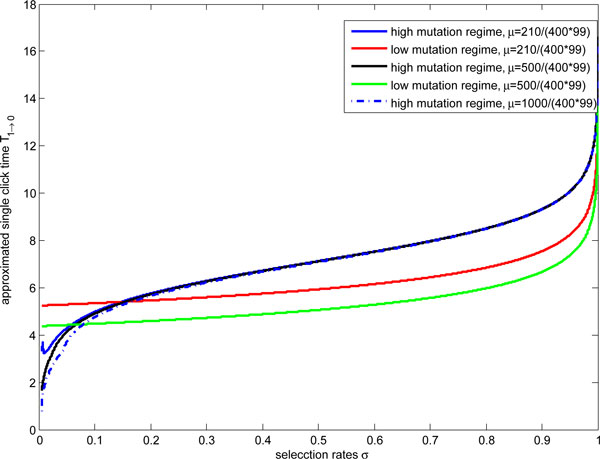
The approximated single click time decreases with mutation rates increasing in the regime μ ∊ (2N/4N(N - 1), 1) and σ∈((2+2μ-10Nμ+4N2μ+2Nμ2+4(1-μ)N(N-1)((2N-1)μ-1))/(μ-2N+1)2,(2Nμ-1)/(2Nμ-μ)) denoted by I iv). Assume N=100, blue, black and dashed lines, corresponding high mutation rates regime, represent μ=210/(400*99), μ=500/(400*99) and μ=1000/(400*99) respectively. Red and green lines, corresponding low mutation rates regime, represent μ=210/(400*99) and μ=500/(400*99) respectively. The approximated single click time increases with mutation rates increasing in the regime μ (1/(2N-1),1) and σ ((2Nμ-1)/(2Nμ-μ),1) denoted by I iii). Green dotline represents this case.